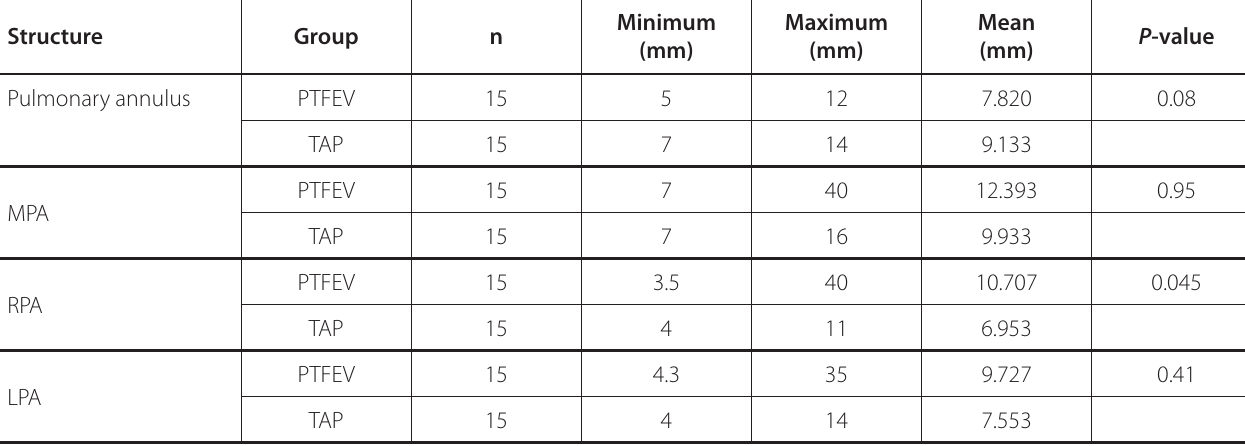
Table 2 . Preoperative pulmonary artery dimensions based on transthoracic echocardiography.